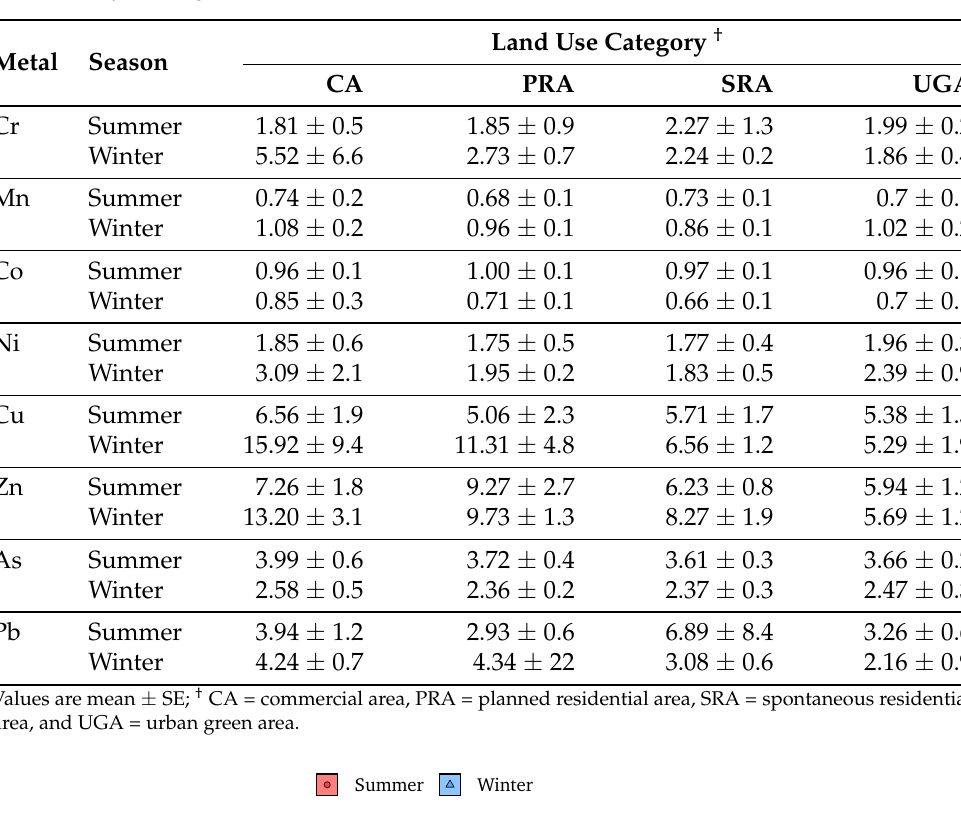
Table 2. Contamination factor ( CF ) of heavy metals in roadside dust for different land-use categories in Dhaka city of Bangladesh.